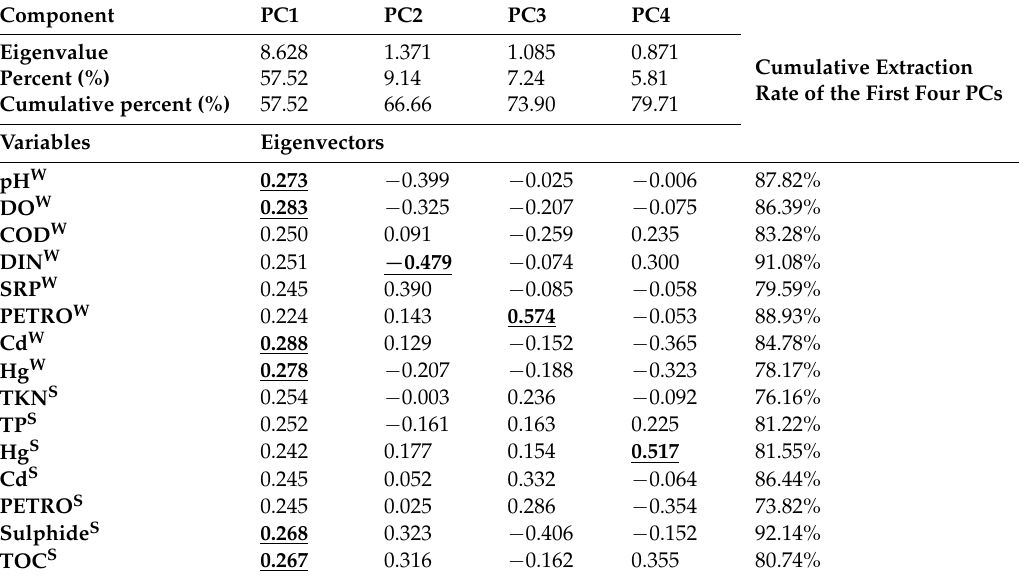
Table 4. MPCA results for selecting the key environmental indicators (KEIs) from the studied samples.